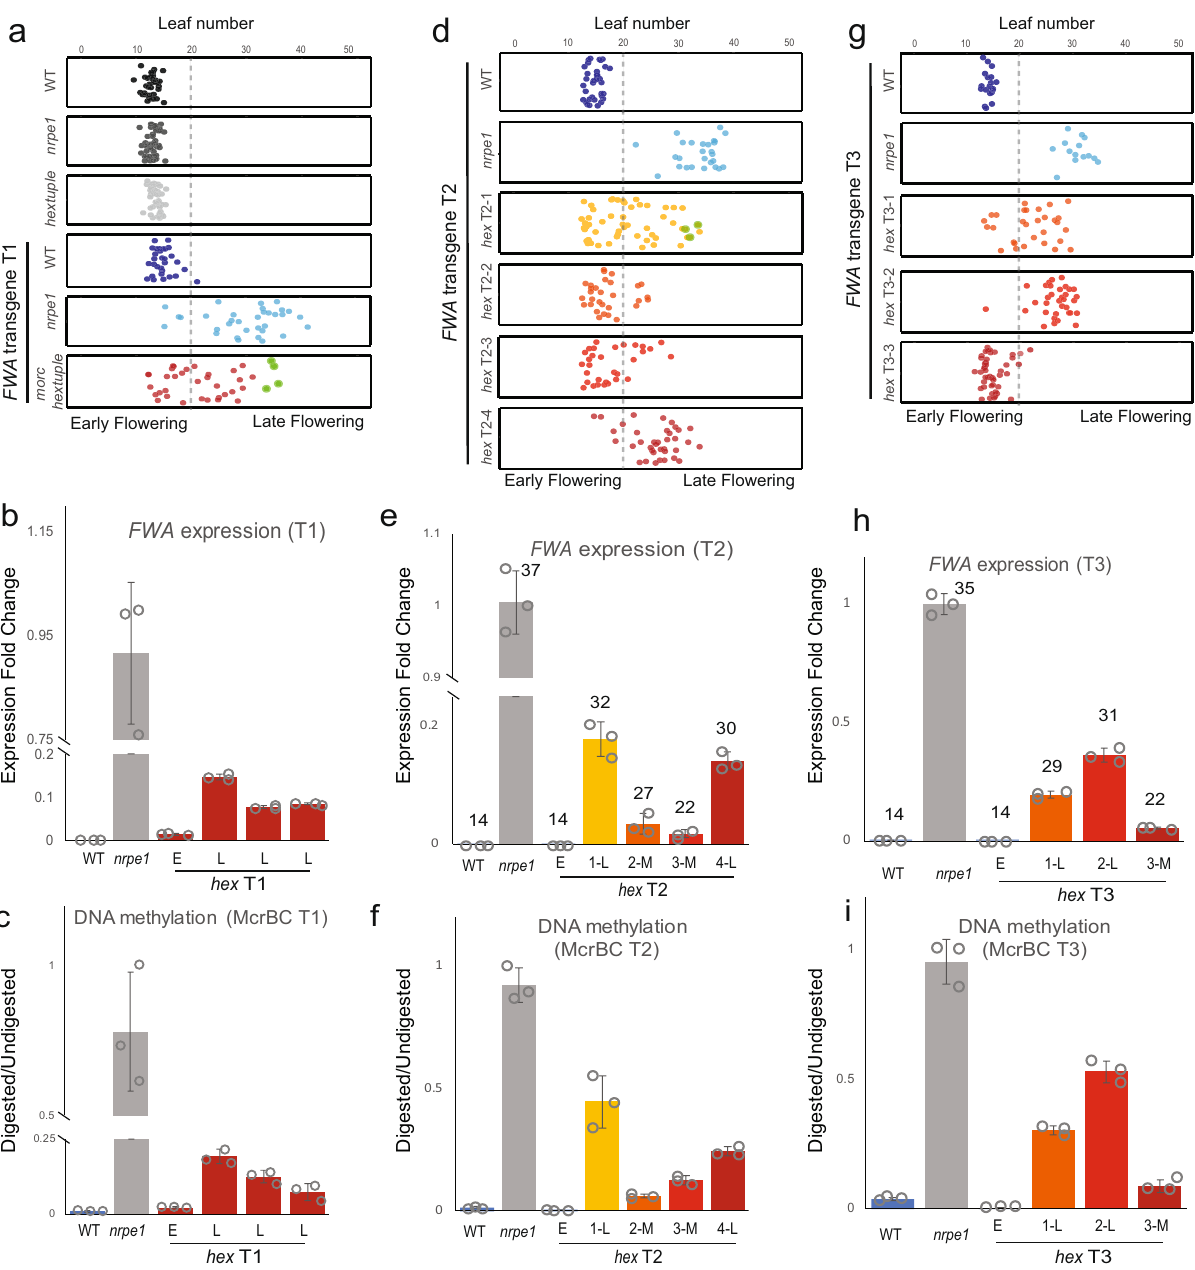
Fig. 6 Transgene silencing is impaired in morc mutants. a Flowering time of T1 plants in wild-type, nrpe1-11 , and morc hex backgrounds as indicated by the leaf number. The green dots represent the four late fl owering plants propagated to the T2 generation. b qRT-PCR of FWA expression of four independent T1 plants in hex backgournd (crimson) relative to that in nrpe1 background (gray). Error bars represent the mean ± s.d. of 3 technical replicates. c McrBC analysis of the FWA promoter of the same representative T1 plants displayed in b . Error bars represent the mean ± s.d. of 3 technical replicates. E represents early fl owering and L represents late fl owering. d Flowering time of T2 plants in wild-type, nrpe1-11 , and the progenitor lines of the four late fl owering T1 hex plants as indicated by the leaf number. The green dots in line T2-1 represent three late fl owering T2 plants propagated to their T3 generation. e qRT-PCR of FWA expression level of one representative early and three late fl owering plants in T2 progenitor lines in hex background, relative to that in nrpe1 background. Leaf number of the corresponding plant is indicated. E early fl owering, M intermediate fl owering, L late fl owering. Error bars represent the mean ± s.d. of 3 technical replicates. f McrBC analysis of the FWA promoter of the same T2 progenitor lines displayed in e . Error bars represent the mean ± s.d. of 3 technical replicates. E represents early fl owering and M indicates intermediate fl owering. E early fl owering, M intermediate fl owering, L late fl owering. g Flowering time of T3 plants in wild-type, nrpe1-11 , and the progenitor lines of the three late fl owering T2-1 morc hex line as indicated by the leaf number. E early fl owering, M intermediate fl owering, L late fl owering. h qRT-PCR of FWA expression level of one early fl owering and three representative late fl owering plants in T3 progenitors derived from T2-1. Leaf number of the corresponding plant is indicated. Error bars represent the mean ± s.d. of 3 technical replicates. E early fl owering, M intermediate fl owering, L late fl owering. i McrBC analysis of the FWA promoter of the same representative T3 plants displayed in i . Error bars represent the mean ± s.d. of 3 technical replicates. E early fl owering, M intermediate fl owering, L late fl owering. Source data underlying Fig. 6 are provided as a Source Data fi